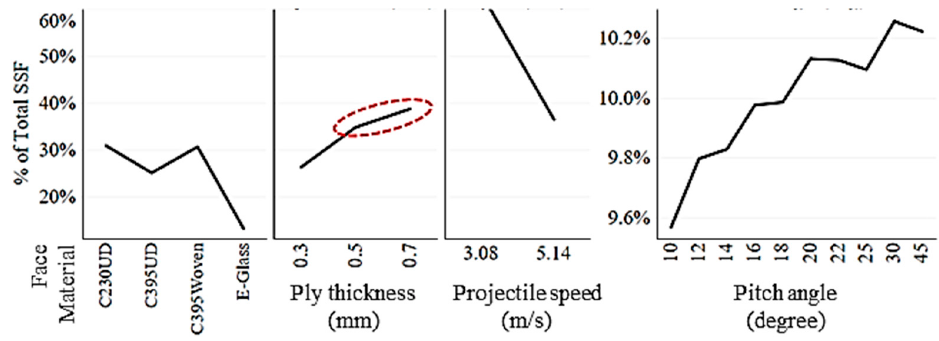
Figure 10. Parametric trends for Bouligand composite. Red ellipse indicates insignificant range.